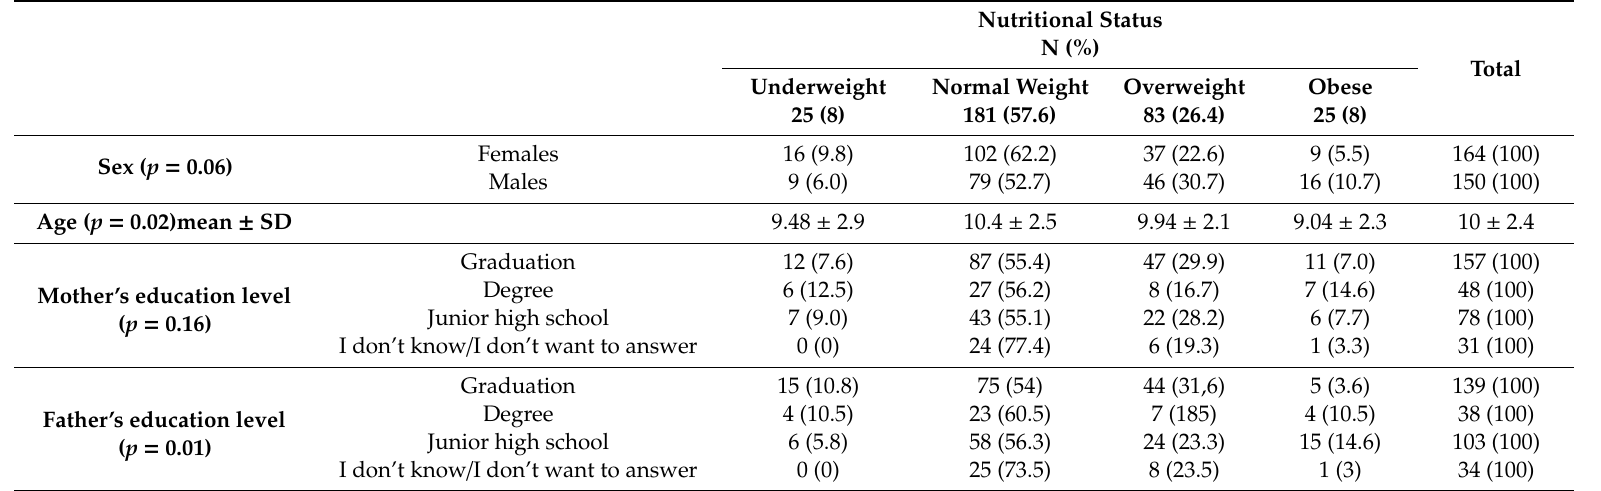
Table 4. Gender and age by nutritional status.